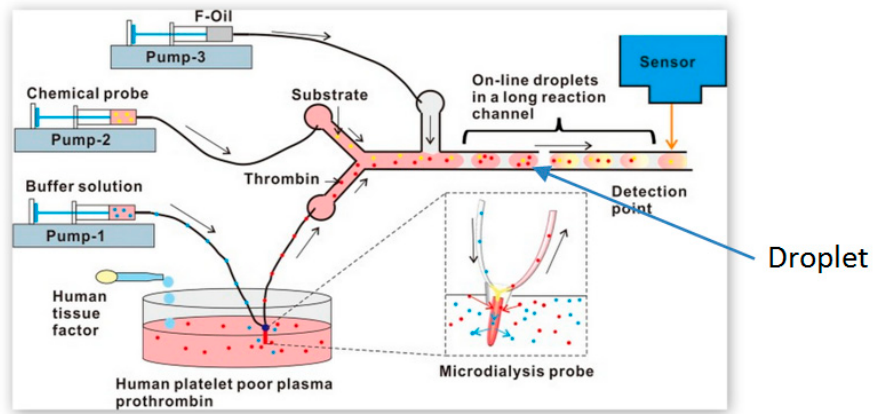
Figure 3. Schematic representation of droplet-based microfluidic device with a long channel for continuous analysis of thrombin generation in real-time. Taken with permission from [33].